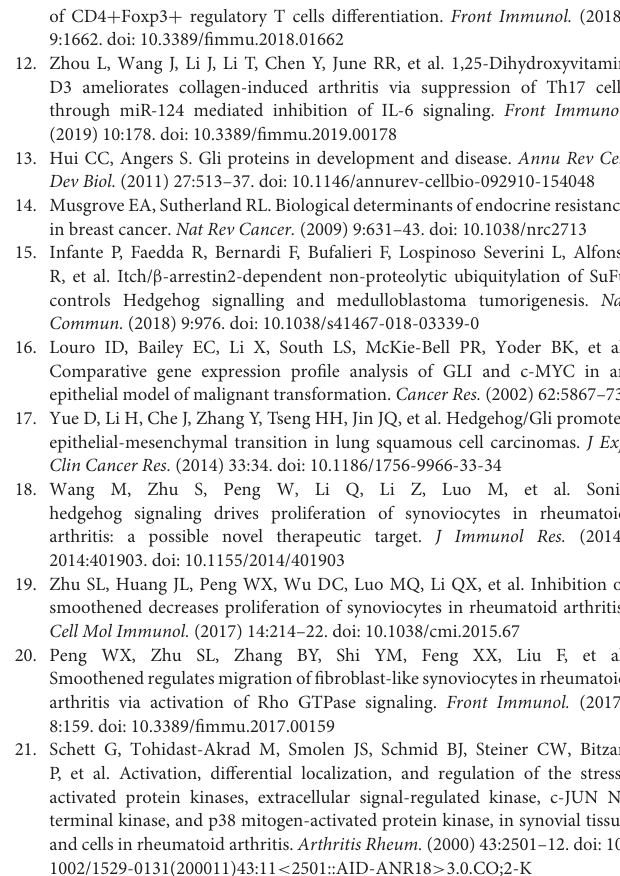
Supplementary Figure 1 | Cell morphology and detection of surface molecules of FLSs. (A) FLSs at passage 3 were characterized as spindle-cell morphology under a light microscope (100 × magnification). (B) The surface molecules CD90, CD68, CD11b, FcgRII, and FcgRIII receptor were detected by flow cytometry. Supplementary Figure 2 | Effect of SHH-JNK signaling on IL-6 and IL-8 expression in FLSs. (A) The mRNA expression of IL-6 and IL-8 was determined by real-time PCR after FLSs were treated with SAG (1 µ M) or SAG in the presence of SP600125 (20 µ M) for 24h. (B) The expression of IL-6 and IL-8 in cell culture supernatants was measured by an ELISA. The results are shown as the mean ± S.D. Data were analyzed using ANOVA and post hoc comparisons were made